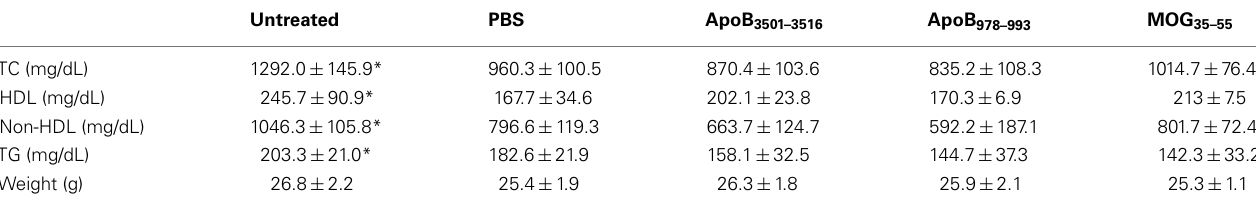
Table 3 | Lipid profile of